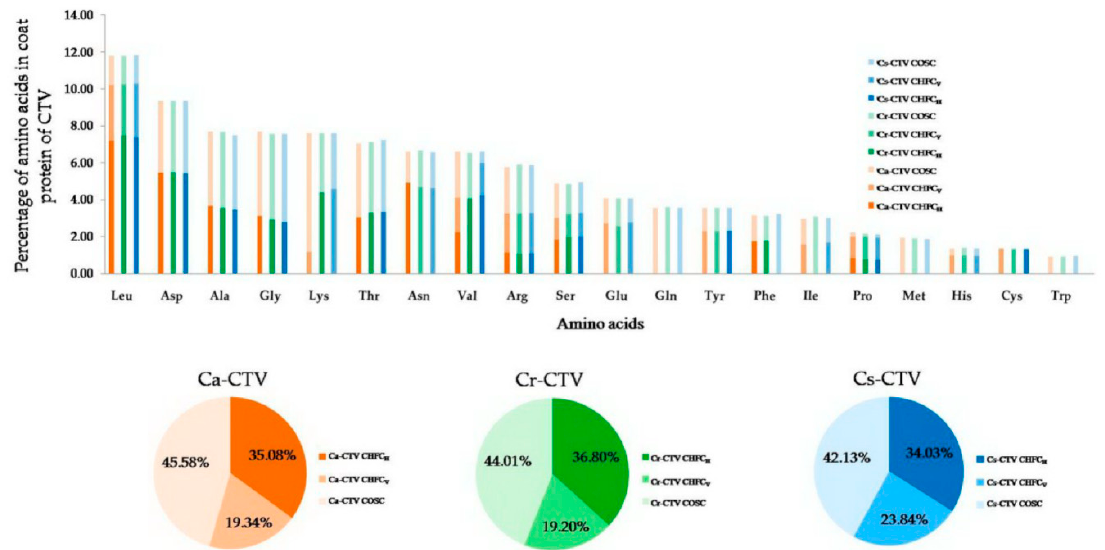
Figure 5. Contribution of high-frequency codons. Bar diagram showing the percentage of 20 amino acids in the coat protein of the three CTV subgroup isolates. Different color stacked bars indicate the percentages of amino acid encoded by the host-preferred high-frequency codon (HFC H ), virus-preferred high-frequency codon (HFC V ) and the other synonymous codon (OSC). CHFC H , CHFC V , and COSC denote contributions of host-preferred high-frequency codon, virus-preferred high-frequency codon, and other synonymous codon. Pie diagram represents the percentages of CHFC H , CHFC V , and COSC encoded amino acids in coat protein of different CTV subgroups. Different CTV subgroups are indicated with different color markers as shown to the right of the